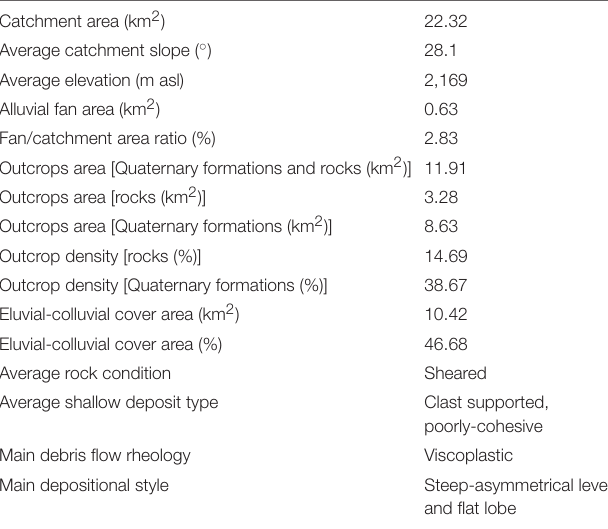
TABLE 1 | A synthesis of the Rio Frejus catchment characteristics (modified from Tiranti and Deangeli, 2015).